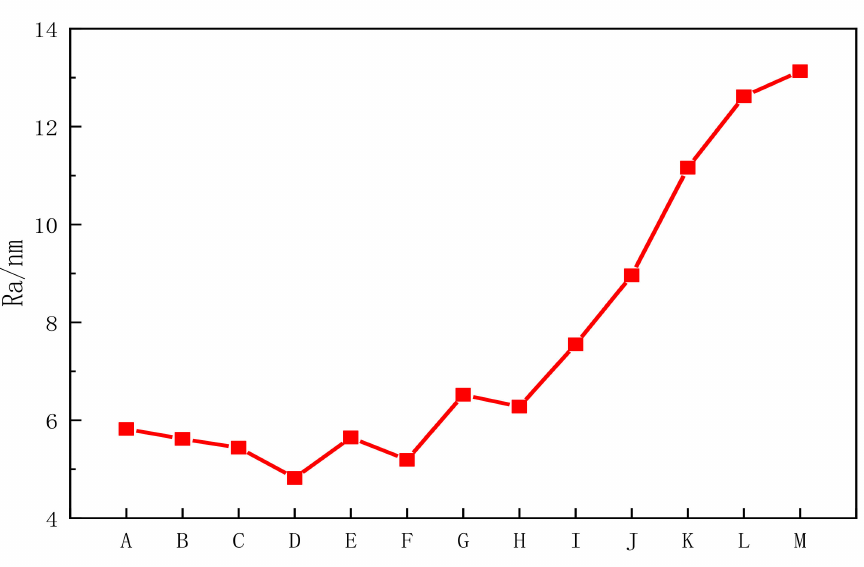
Figure 7. Average roughness (Ra) change in the (TiCrV)x-(TaW)1-x (A-M) binary system HEA films. Correspondingly, the surface morphology also changed in stages. When x = 0.36, the main components of the film were Ta and W components, which had a BCC structure, and a relatively regular column-like crystal structure was formed on the surface. The film